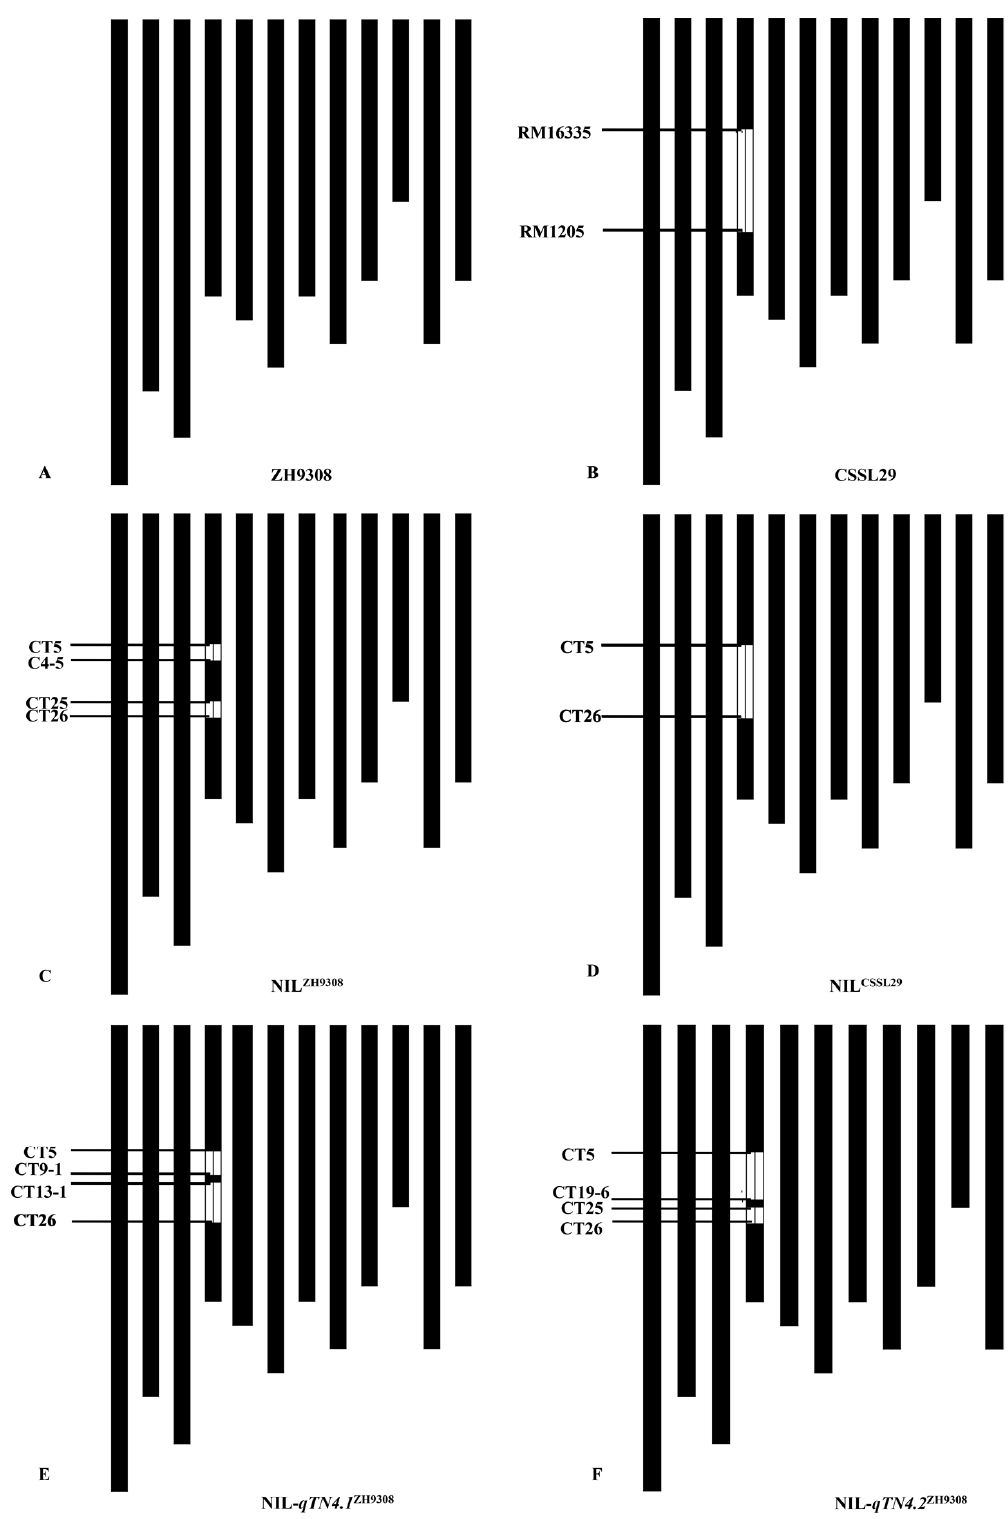
Figure 1. The genotype of ZH9308, CSSL29 and four NILs. ( A ) The genotype of ZH9308. ( B ) The genotype of CSSL29. ( C ) The genotype of NIL ZH9308 . ( D ) The genotype of NIL CSSL29 . ( E ) The genotype of NIL- qTN4.1 ZH9308 . ( F ) The genotype of NIL- qTN4.2 ZH9308 . The black regions indicate that the regions are homozygous for the ZH9308 genome. The white ones indicate that the regions are homozygous for the XQZB genome. NILs, near-isogenic lines.